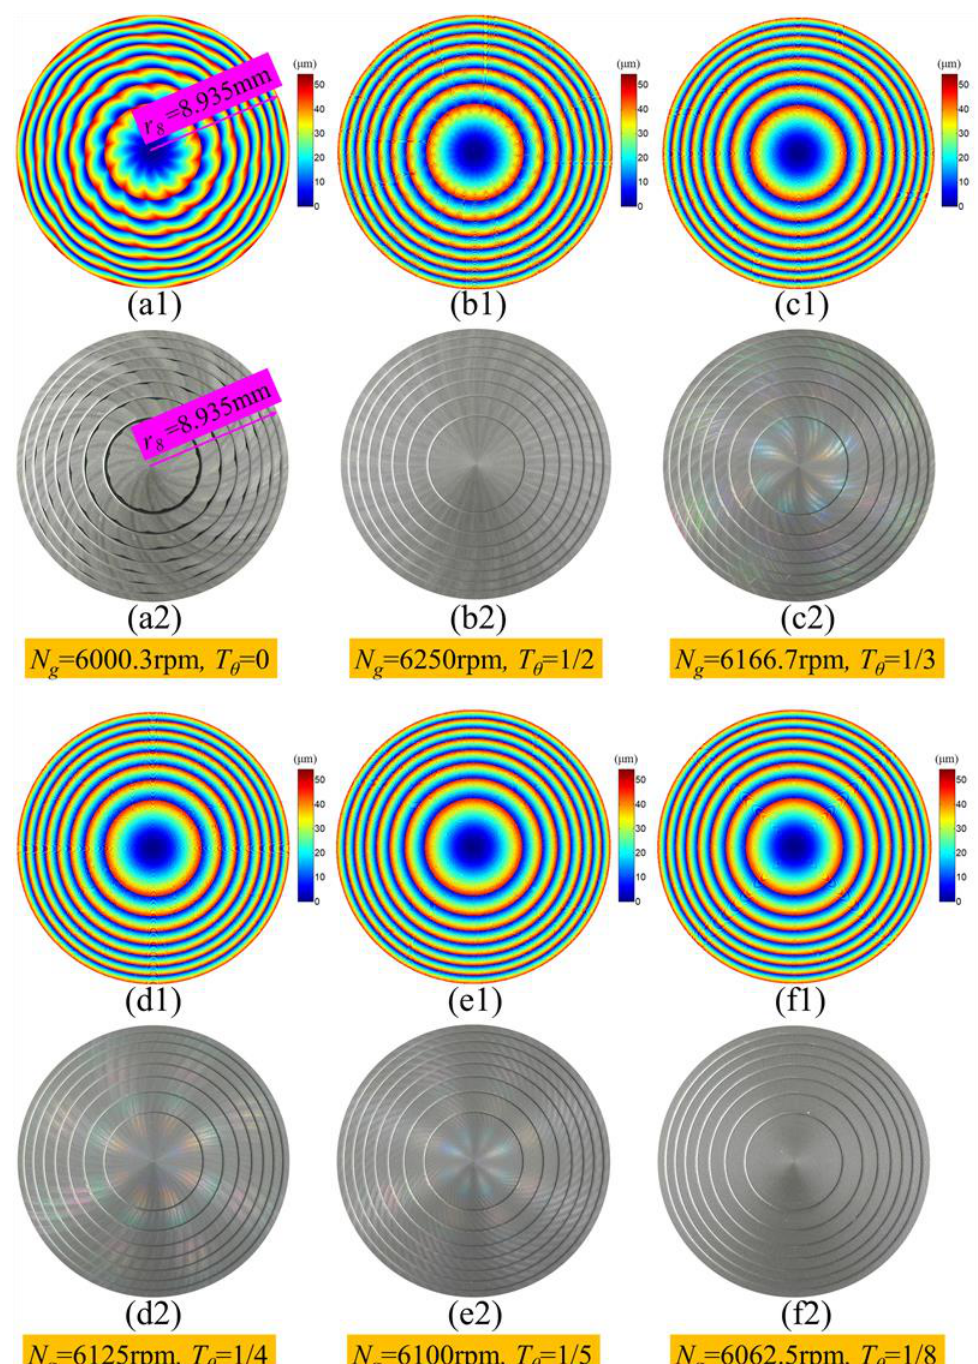
Figure 11. Simulation and the experiment result of the surface waviness topography of the ground Fresnel micro-structured molds: ( a1 – f1 ) the simulation results; ( a2 – f2 ) the photos of the workpiece.